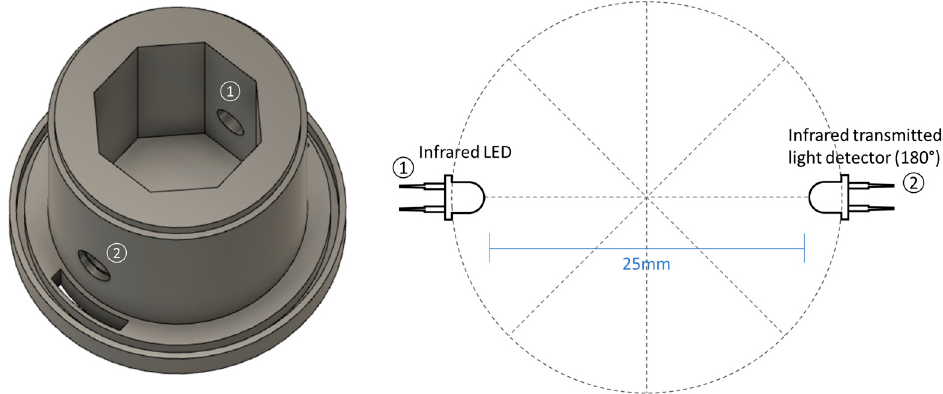
Figure 1. Three-dimensional drawing of the probe comprising the optical transducers ( left image ) and scheme of the positions of the LED (1) and the transmitted light detector (2) ( right image ).